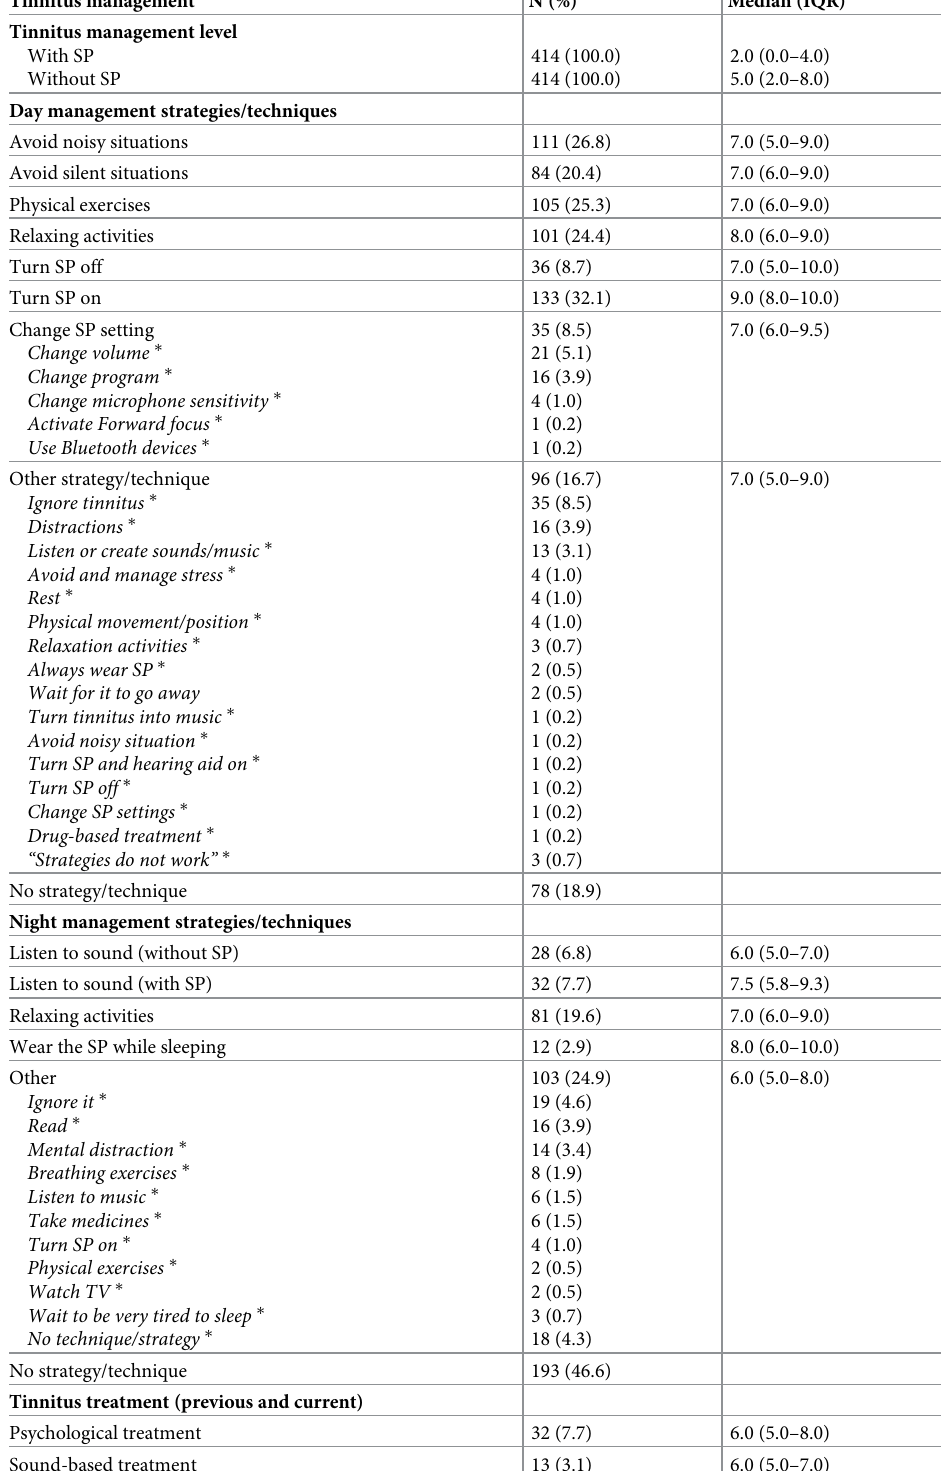
Table 6. Tinnitus management strategies and